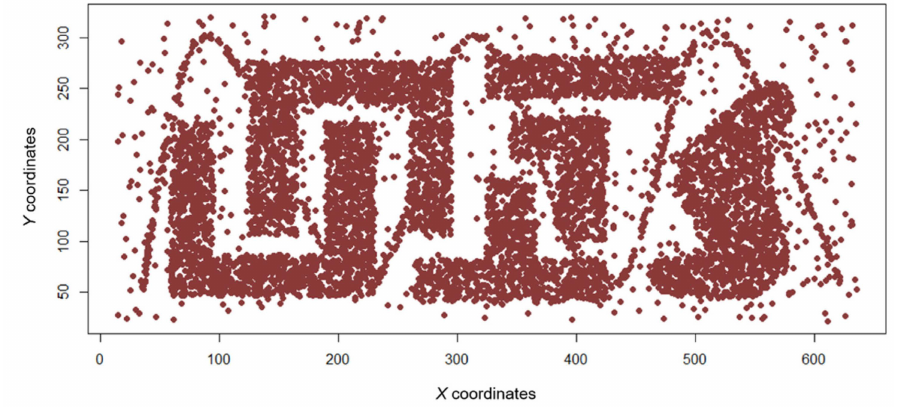
Figure 4. Spatial distribution of the t4.8k